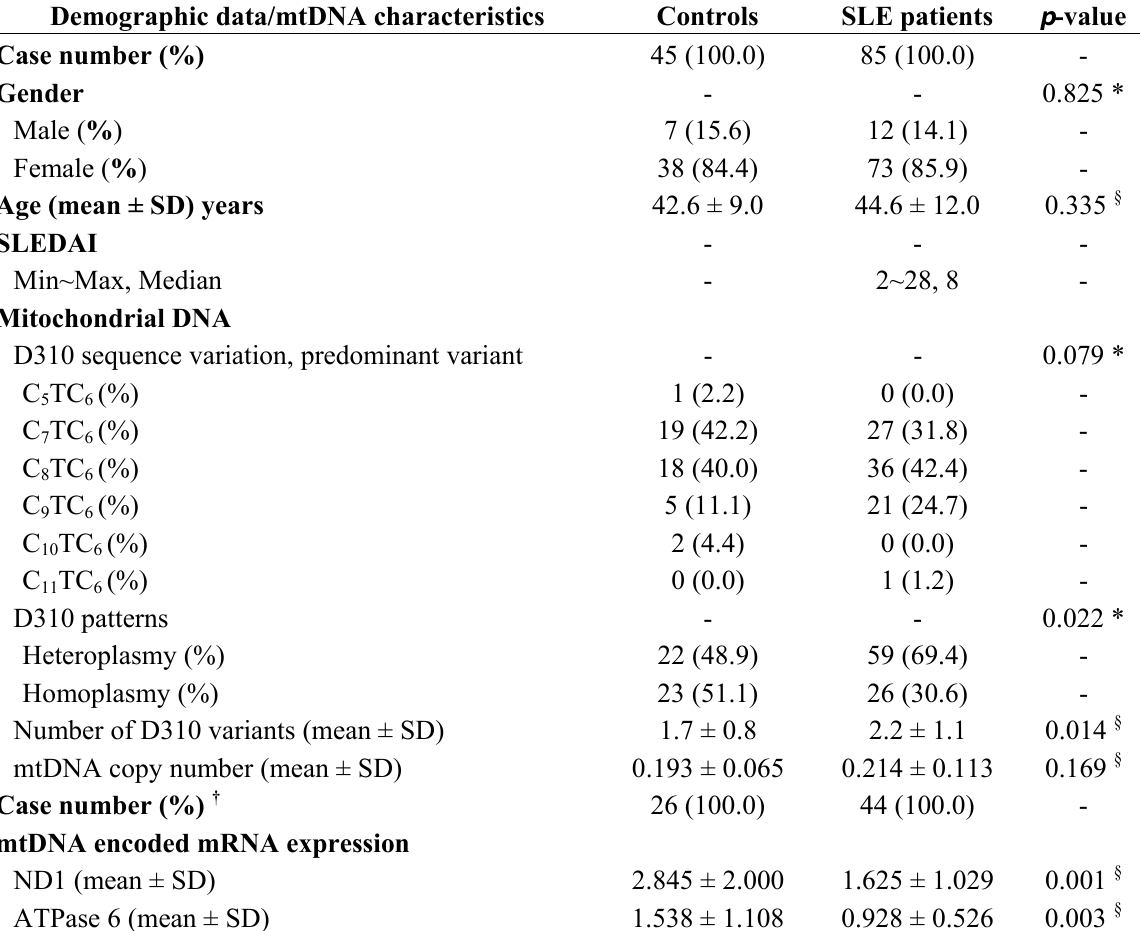
Table 1. Demographic data and mtDNA characteristics of normal controls and systemic lupus erythematosus (SLE)